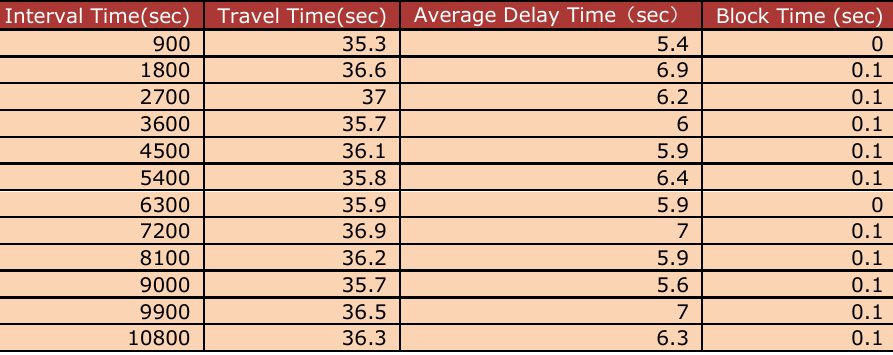
Table 6. Itinerary and the Delay Statistics at the 2 nd Congestion